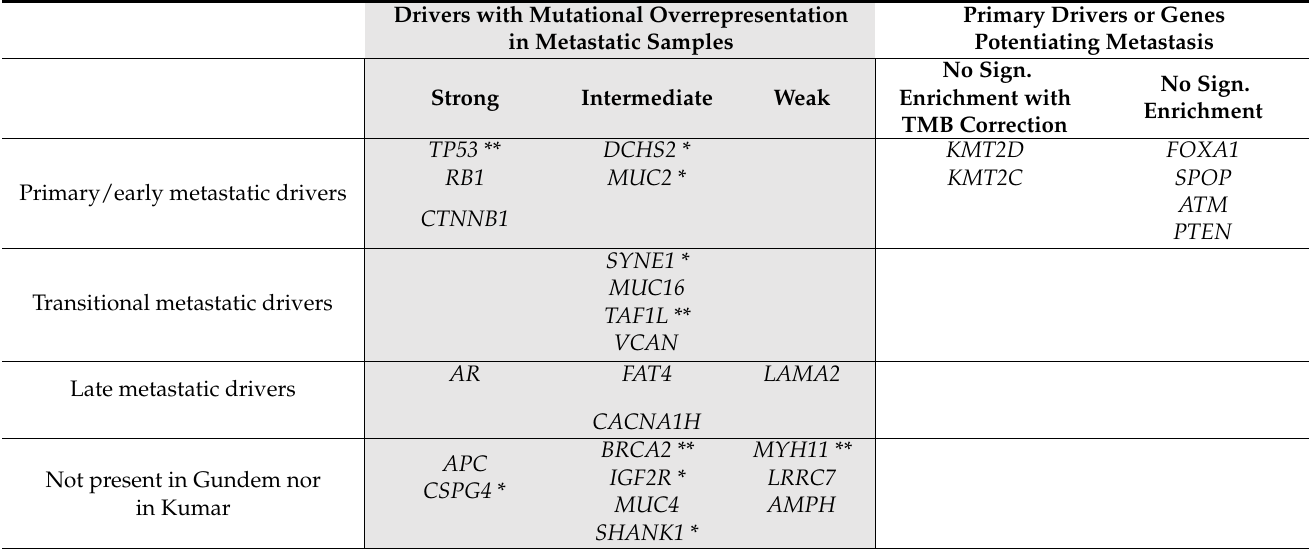
Table 2. Classification of the driver genes identified by GoNetic according to the mutational enrichment in metastatic cohorts (columns) and their association with tumor evolution (rows). Columns : Mutational enrichment signal in metastatic samples is divided into five categories (gray background): strong = genes significantly enriched in mutations in the HMF and ARM cohorts even after TMB correction, intermediate = genes significantly enriched in mutations in both the HMF and ARM cohorts without TMB correction but in one cohort after TMB correction, weak = genes significantly enriched in mutations with TMB correction in one metastatic cohort only. The two last categories correspond to frequently mutated genes that i) were enriched in mutations in both metastatic cohorts but only without TMB correction (no sign. enrichment with TMB correction) and ii) for which no enrichment at all could be detected, even not without correcting for TMB (no sign. enrichment). Rows : The primary/early metastatic category corresponds to genes for which mutations were present in the primary tumor (when available) and truncal to the matching metastases in most of the patients. The transitional category corresponds to genes for which mutations were truncal in the majority of the patients but not present in the primary tumor. The late category corresponds to genes for which mutations were non-truncal to metastatic lesions and never detected in the matching primary tumor. Drivers with Mutational Overrepresentation Primary Drivers or Genes in Metastatic Samples Potentiating Metastasis No Sign. No Sign. Enrichment with Strong Intermediate Weak TMB Correction